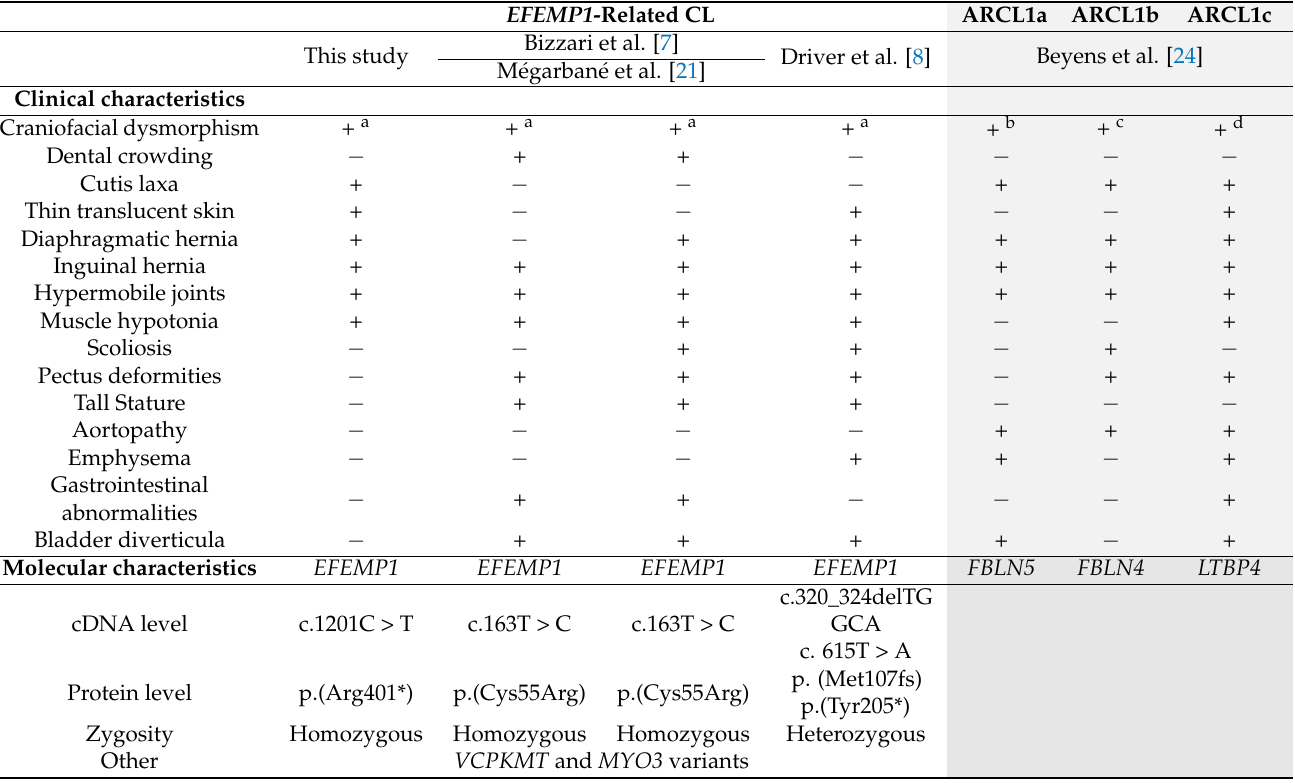
Table 1. Summary of molecular and clinical characteristics of individuals with EFEMP1 pathogenic variants and comparison with ARCL type